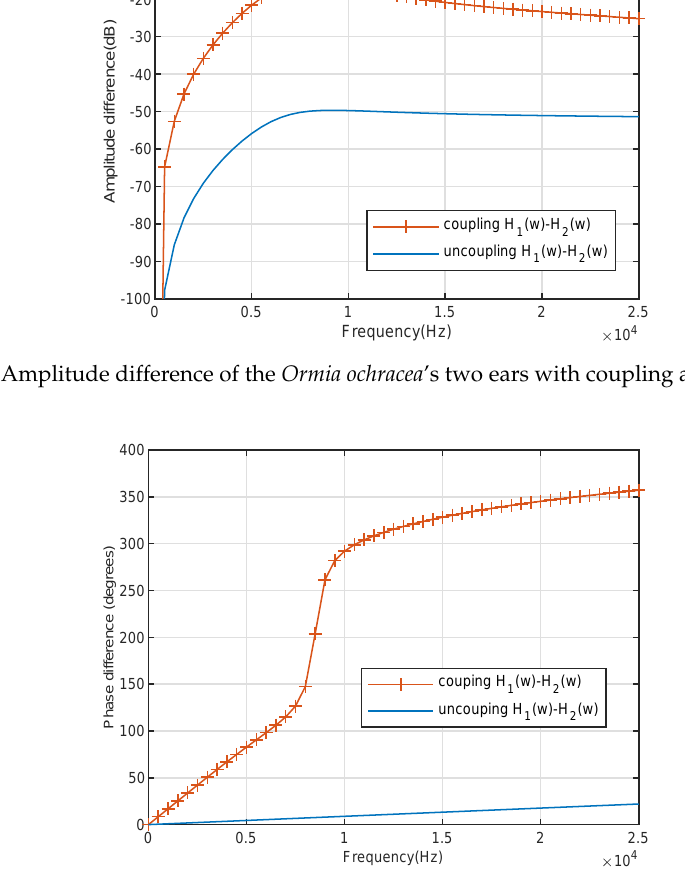
Figure 4. Phase difference of the Ormia ochracea ’s two ears with coupling and